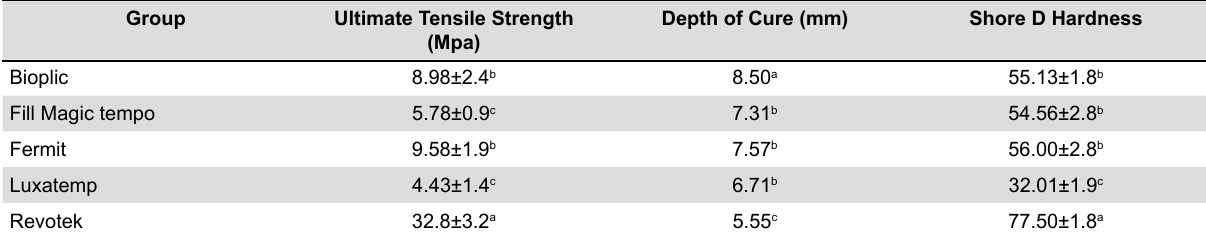
Table 1- Mechanical properties of the different materials tested (Mean ± SD)